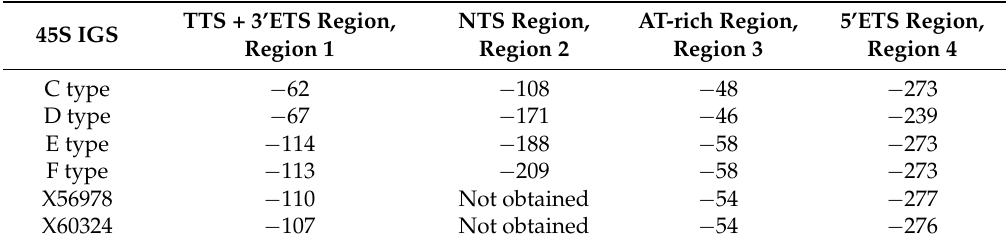
Table 4. Maximum negative dG (predicted free energies, kcal ¨ mol ´ 1 ) values obtained during putative secondary structure formation in four different regions (R) of 45S IGS.